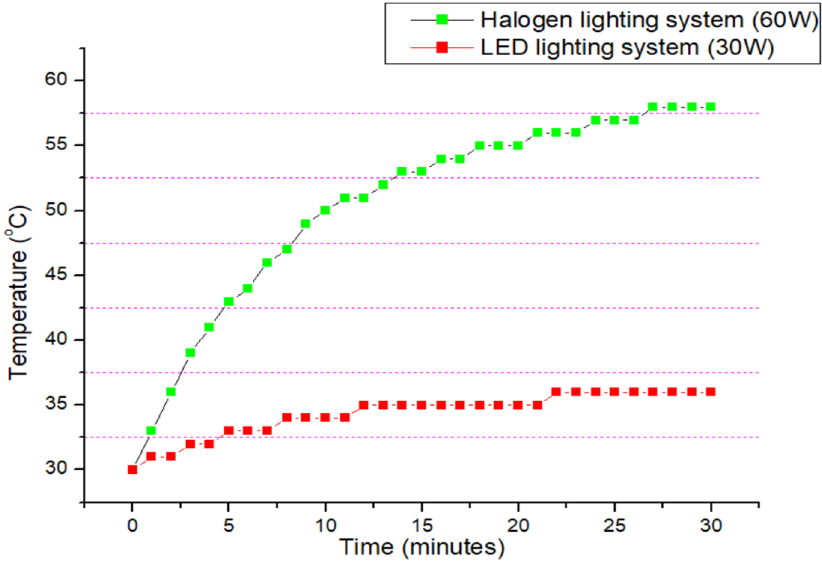
Figure 8. Temperature measurements of the polarizing filters in the halogen and LED lighting systems after 30 min.